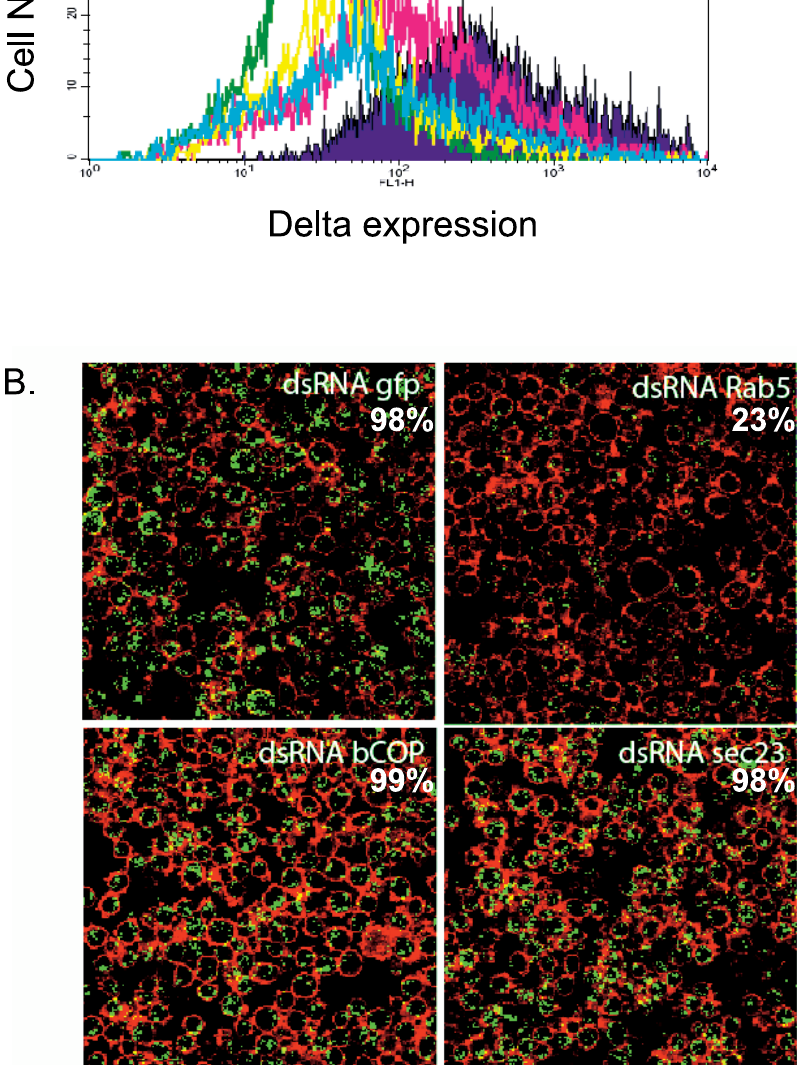
Figure 2. COPI Is Specifically Required for DCV Replication Postentry (A) FACS analysis demonstrates that COPI (betaCOP) and COPII (sec23) are required for Delta secretion. DeltaWTNdeMYC cells were treated with dsRNA and subsequently Delta expression was induced for 2 h. Extracellular Delta expression was monitored by FACS. The bar was set such that 98% of the total uninduced cells were negative for Delta staining. Induction leads to a shift in the population to express surface Delta, such that only 31% of the cells remain negative. Under these conditions, COPI, COPII, and SREBP block surface staining. (B) DCV entry requires endocytosis (Rab5) but not COPI (bCOP) or COPII (sec23) function. Cells were pretreated with dsRNA, infected at 4 8 C to allow surface binding, followed by 3 h at 25 8 C to release the block to endocytosis and monitor viral trafficking. Viral uptake was measured by determining the percentage of cells (red) that contained virus (green). Green, anti-DCV; red, Alexa-fluor-568-phalloidin. DOI: 10.1371/journal.ppat.0020102.g002